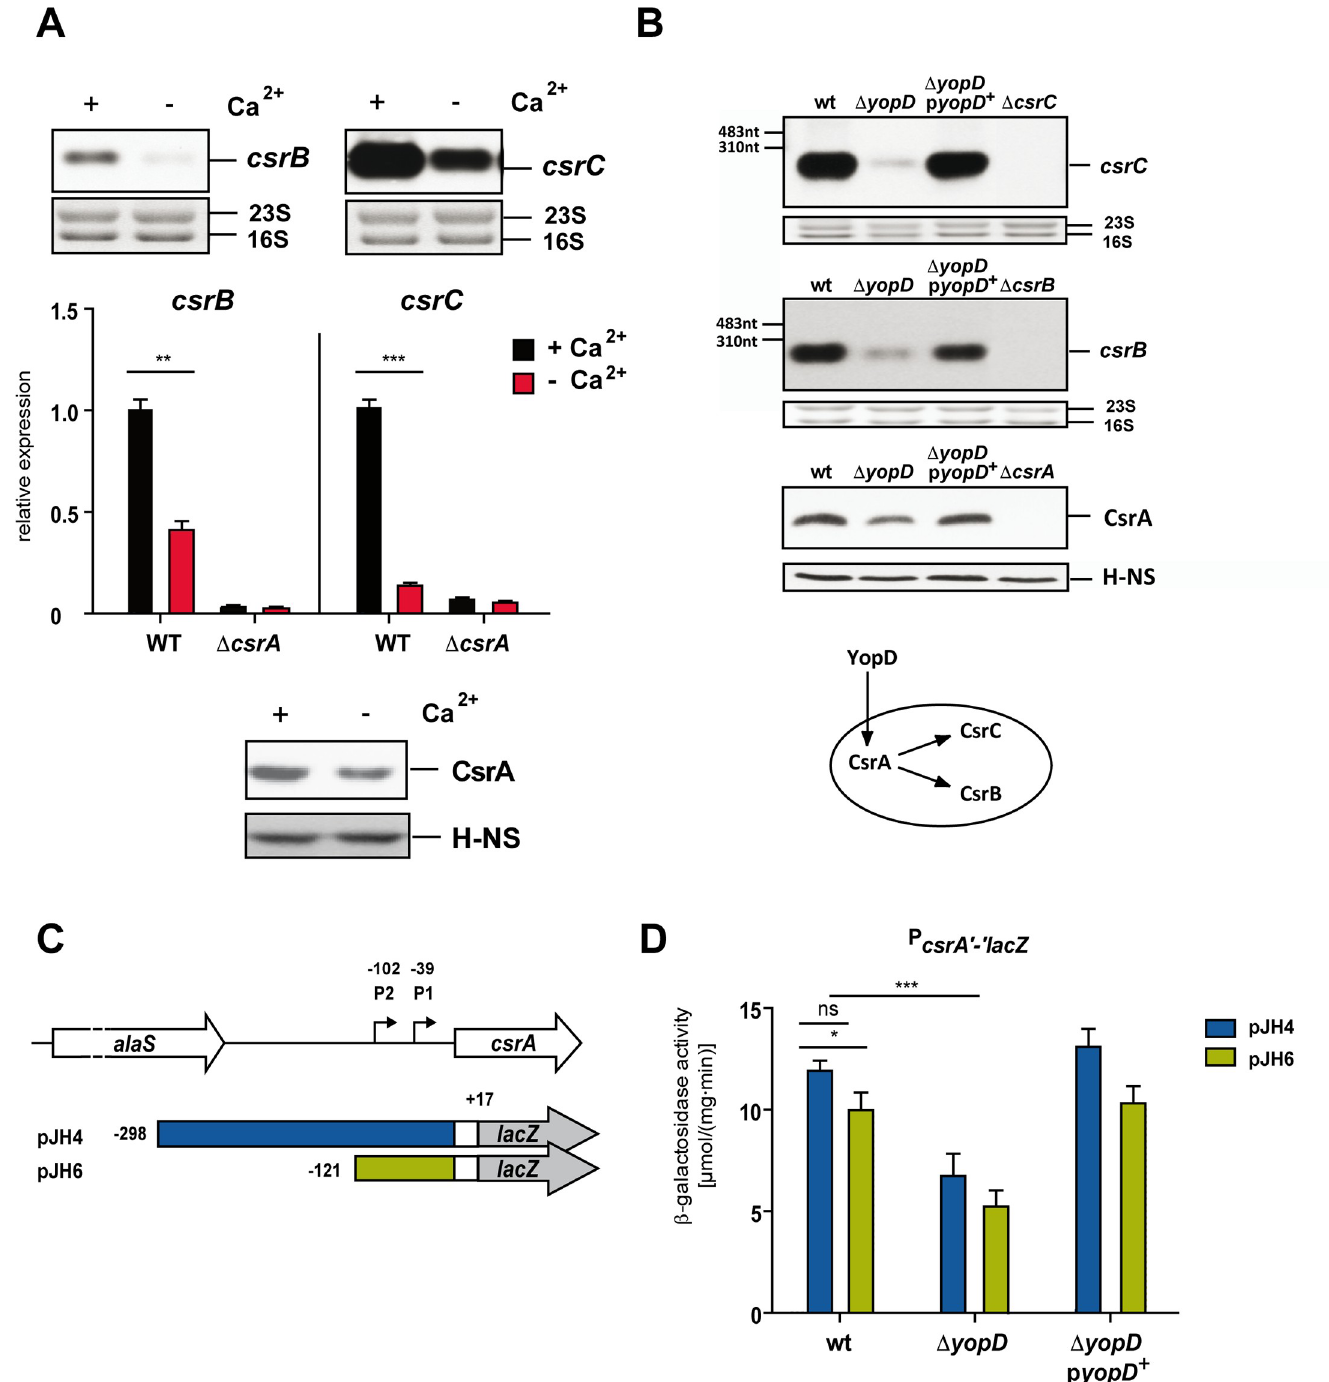
Fig 4. T3SS/Yop-inducing conditions and YopD manipulate expression of the Csr system. (A) Y . pseudotuberculosis strains YPIII (WT) and YP53 ( Δ csrA ) were grown to exponential phase (OD 600 of 0.5) at 25˚C and then shifted to 37˚C in the presence (-) or absence of Ca 2+ (-) by addition of 20 mM sodium oxalate and 20 mM MgCl 2 . After growth for additional 4 h total RNA of the non-induced and induced cultures of WT and the Δ csrA strain was prepared. Upper panel: Total RNA of the WT strain was subjected to northern blotting using csrB- and csrC- specific probes. Middle panel: A real-time qRT-PCR analysis was performed with total RNA of YPIII (WT) and YP53 ( Δ csrA ) with specific primers for the csrB and csrC transcripts. Transcript levels were normalized to the sopB reference transcript and are shown as relative expression to the wildtype (YPIII) under non-secretion (+Ca 2+ ) and secretion (-Ca 2+ ) conditions. Data represent the mean ± SD of three biological and two technical replicates analyzed with a one sample t-test with �� , P < 0.01, and ��� , P < 0.001. Lower panel: Whole cell extracts of the cultures were separated by SDS- polyacrylamide electrophoresis and CsrA and H-NS proteins were detected by western blot analysis with polyclonal anti-CsrA or anti-H-NS (control) sera. (B) Y .